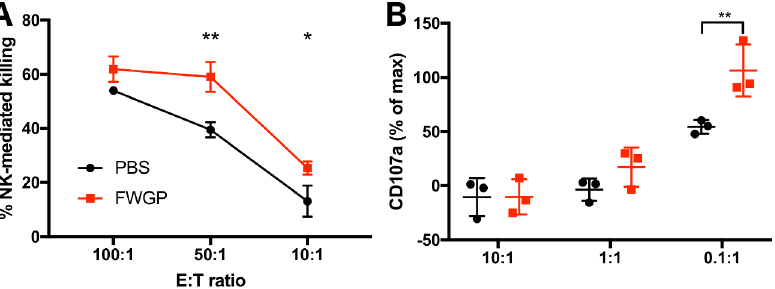
Fig 5. FWGP activates NK cell in immunocompetent mice. BALB/c animalswere treated with FWGP (140 mg/kg) or PBS for 3 days before spleens were dissected. Splenocytes were T-cell depleted and used as effector cells in functionalassays. (A) For killingassays, target cells were CFSE-labeled YAC-1. Data points representthe mean ± SDof the % CFSE + FVD + cells. (B) For degranulation assays YAC-1 cells were used as target. Data points represent the median ± SD fluorescence intensity (as % of max) of CD107astaining. Maximum degranulation was definedas the CD107asignalintensity in cells stimulatedwith PMA+ionomycin (n = 3; * p < 0.05, ** p < 0.01;2-way ANOVA with Sidak’s